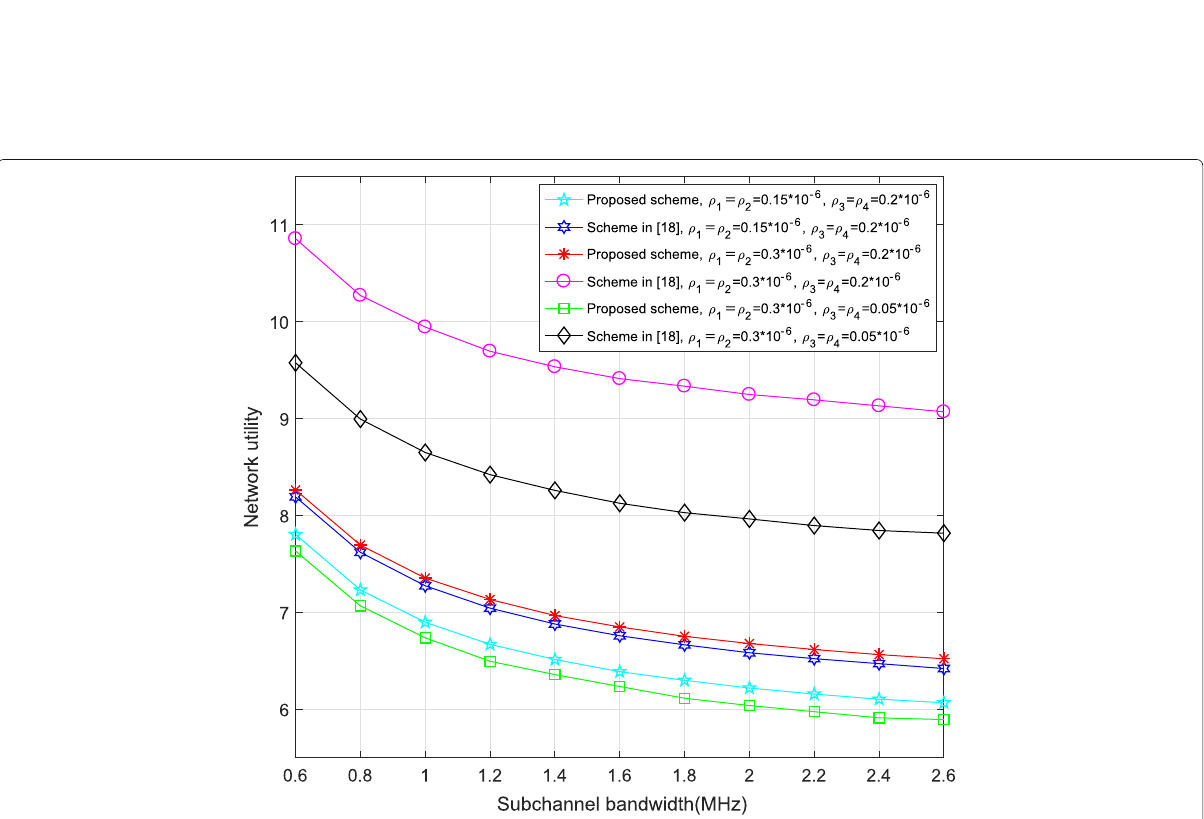
Fig. 7 Network utility versus subchannel bandwidth (different unit price of caching contents at GAPs). The network utility of the system versus the subchannel bandwidth for different unit price of caching contents at